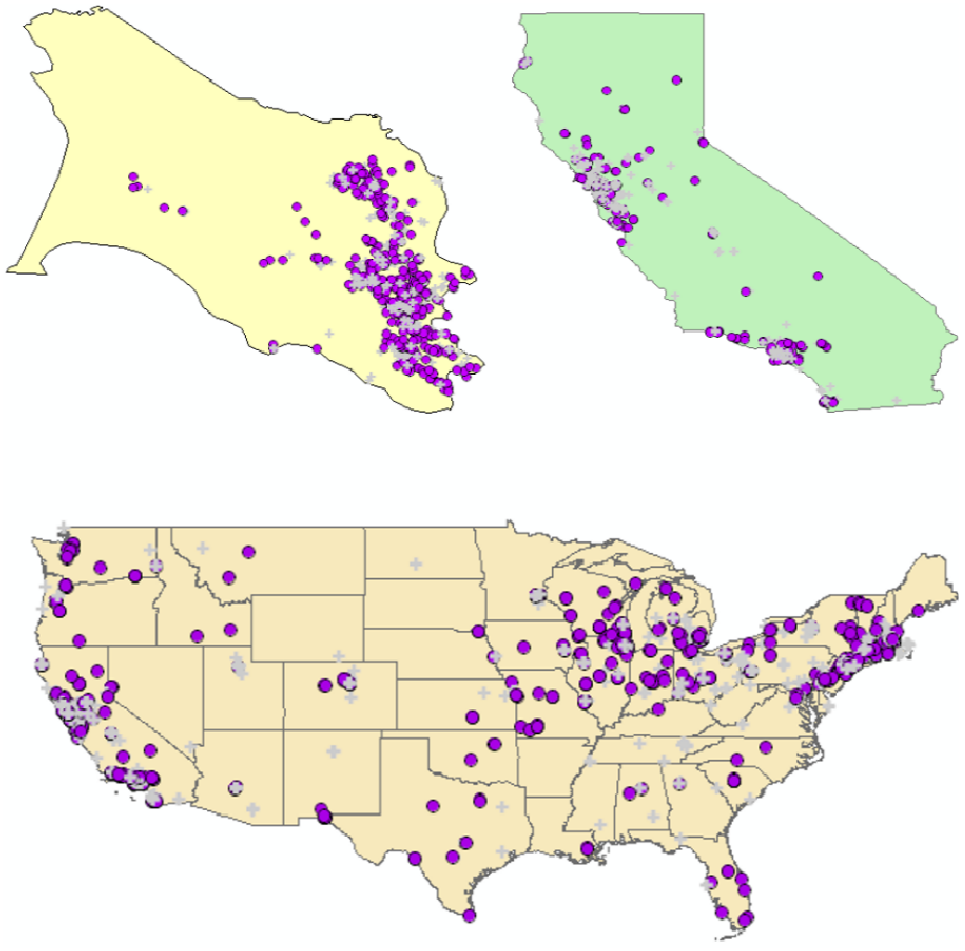
Figure 4. Life course place of residence for study participants in Marin County ( upper left ), California ( upper right ), and from across the United States ( bottom ). Cases are denoted as purple circles, and controls as gray